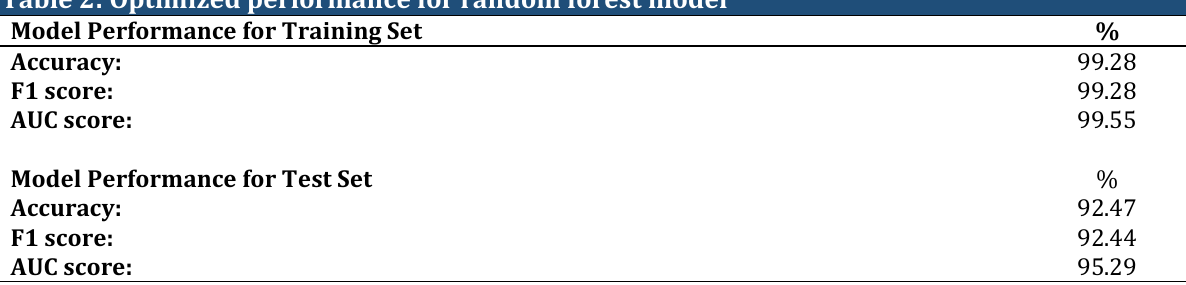
Table 2: Optimized performance for random forest model Model Performance for Training